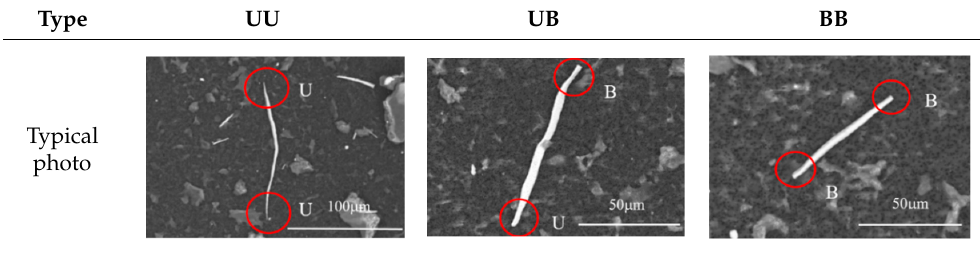
Table 6. The classification of elongated inclusions in the 3R65 and 316L steel grades when using Method 2.